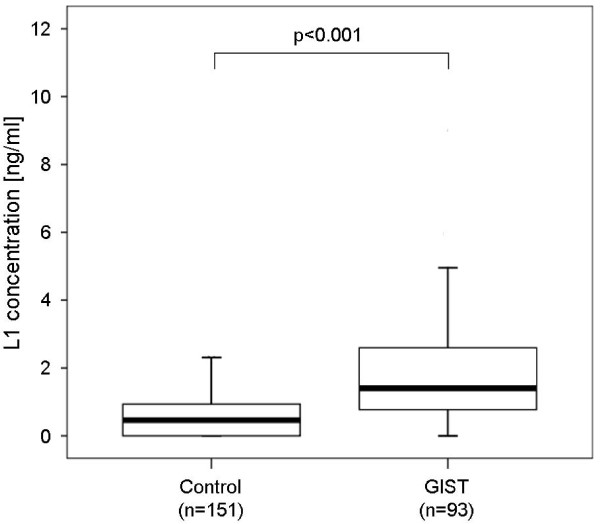
Box-plots show medians (black lines) of soluble L1 concentrations in healthy controls (n = 151) and GIST patients (n = 93) determined by ELISA. Statistical significance was determined by the Mann-Whitney U test (p < 0.001).